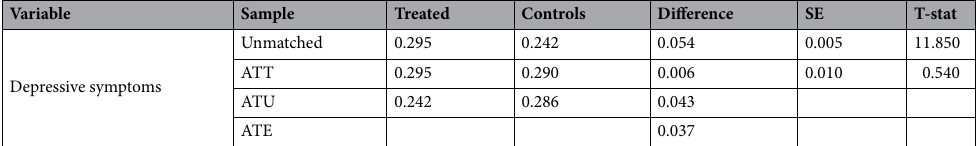
Table 4. The Effect of Multi-Morbidity and different chronic diseases on Depression, Analysis through Propensity Score Matching. ATT average treatment effect on the treated, ATU average treatment effect on the untreated, ATE average treatment effect.